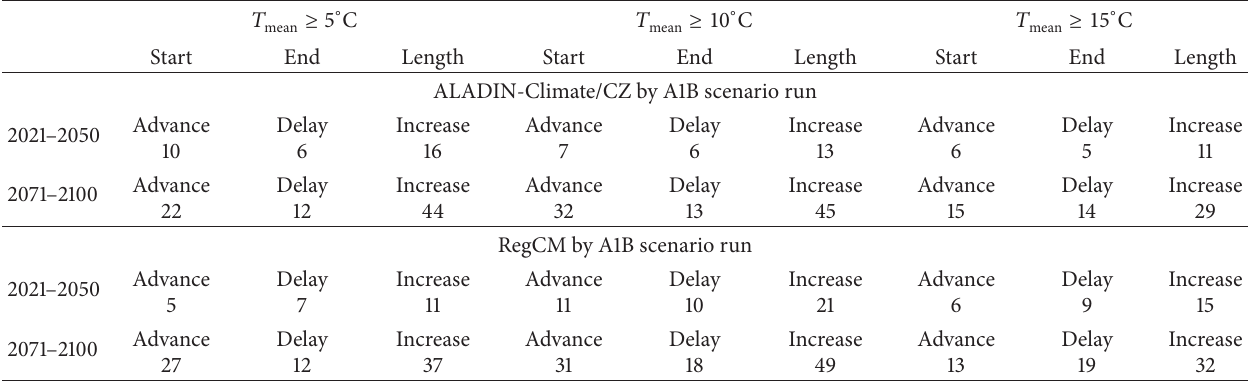
Table 5: Projected changes in the dates of the start, end, and length of the area-averaged growing season for two future periods (2021–2050 and 2071–2100) over the Elbe River